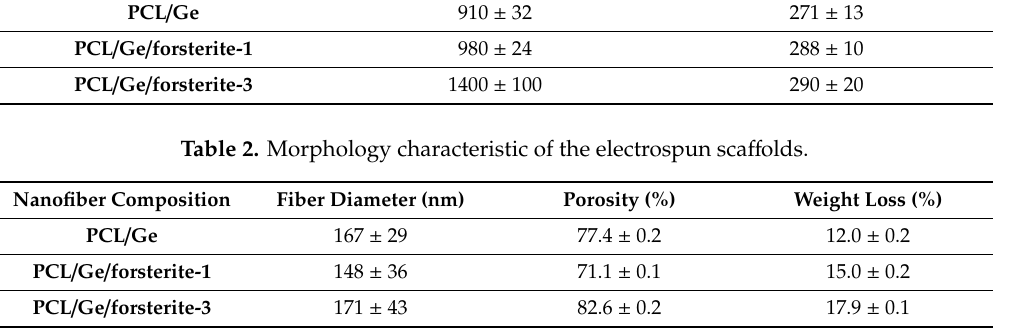
Table 2. Morphology characteristic of the electrospun scaffolds.